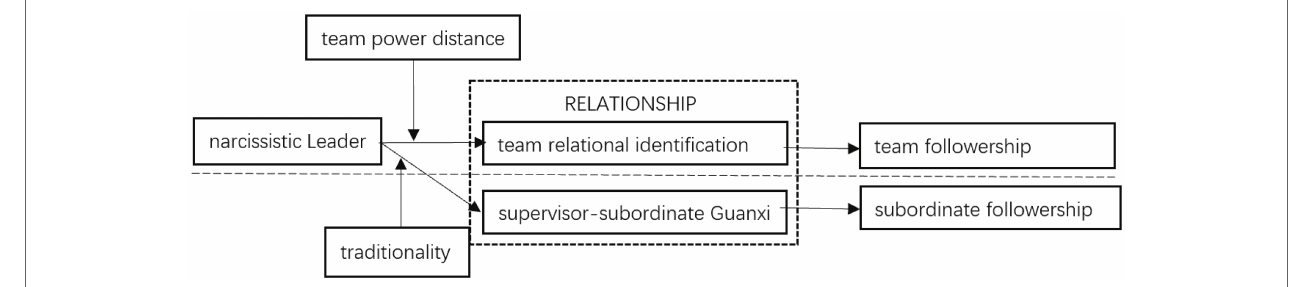
FIGURE 1 | Research